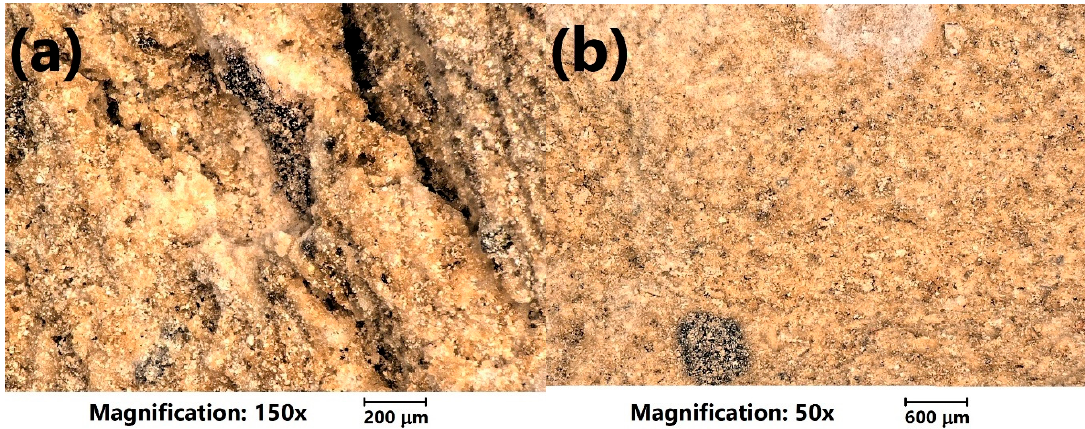
Figure 4. Images of ( a ) C 30 SS 50 , ( b ) C 40 SS 40 , and ( c ) C 50 SS 30 aggregates obtained with optical microscope.